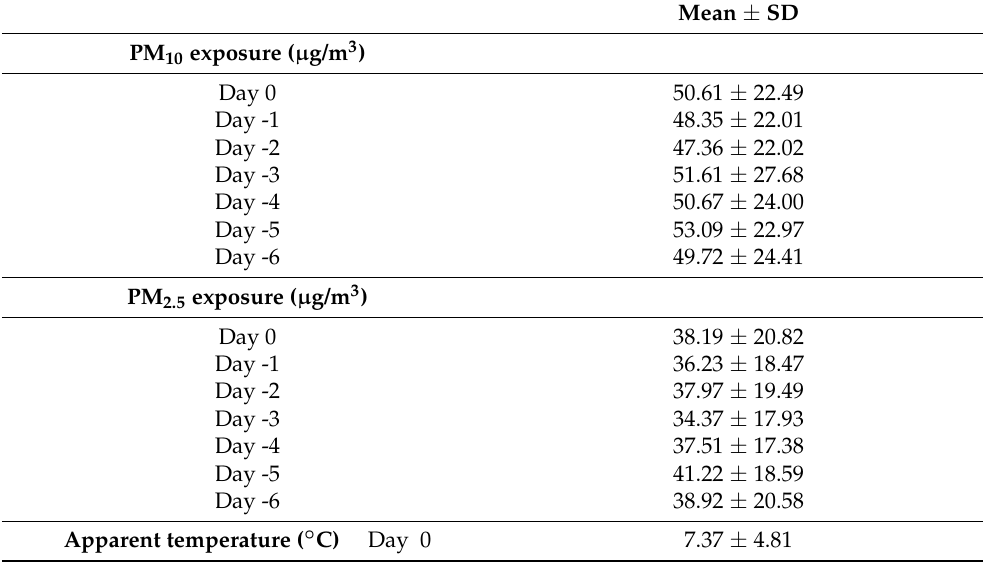
Table 2. Mean concentrations of PM 10 and PM 2.5 exposure evaluated from one week before the enrollment of